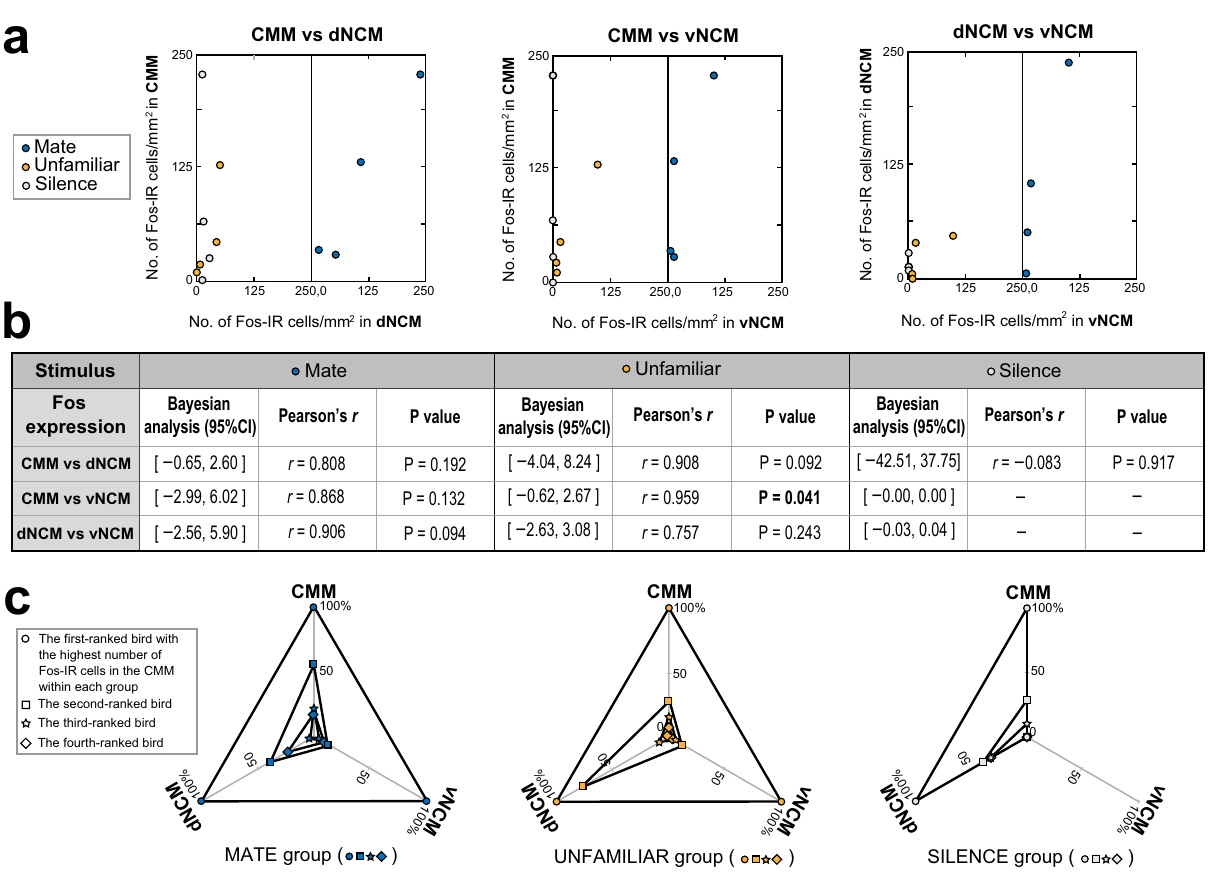
Figure 5. Analysis of correlations in Fos expression between subregions of the caudomedial pallium after CC stimulation. Shown are data with the same conventions as in Fig. 4 but pertaining to the Fos-immunopositive cell counts. Unlike the results revealed by Zenk expression (Fig. 4), there was no linear relationship between subregions for the MATE, the UNFAMILIAR or the SILENCE group with Bayesian